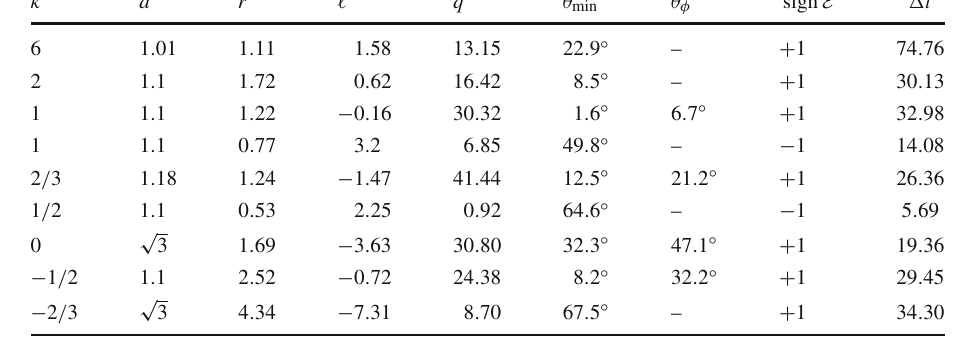
Table 1 Characteristics of the periodic spherical photon orbits in Fig. 9